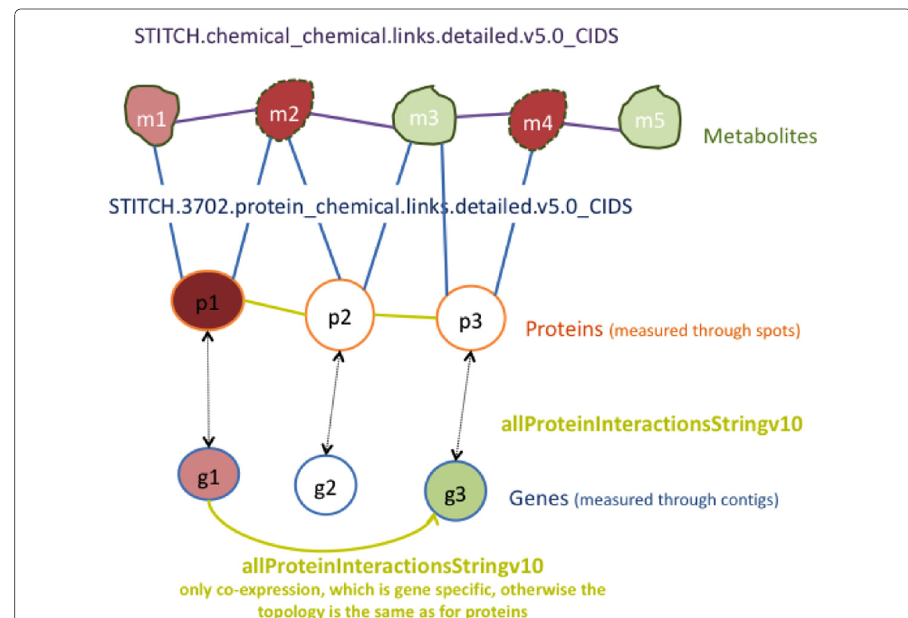
Fig. 8 The network construction from the open databases: Protein-protein interactions are extracted from the STRING database. Metabolite-metabolite and metabolite-protein ones are extracted from the STITCH database